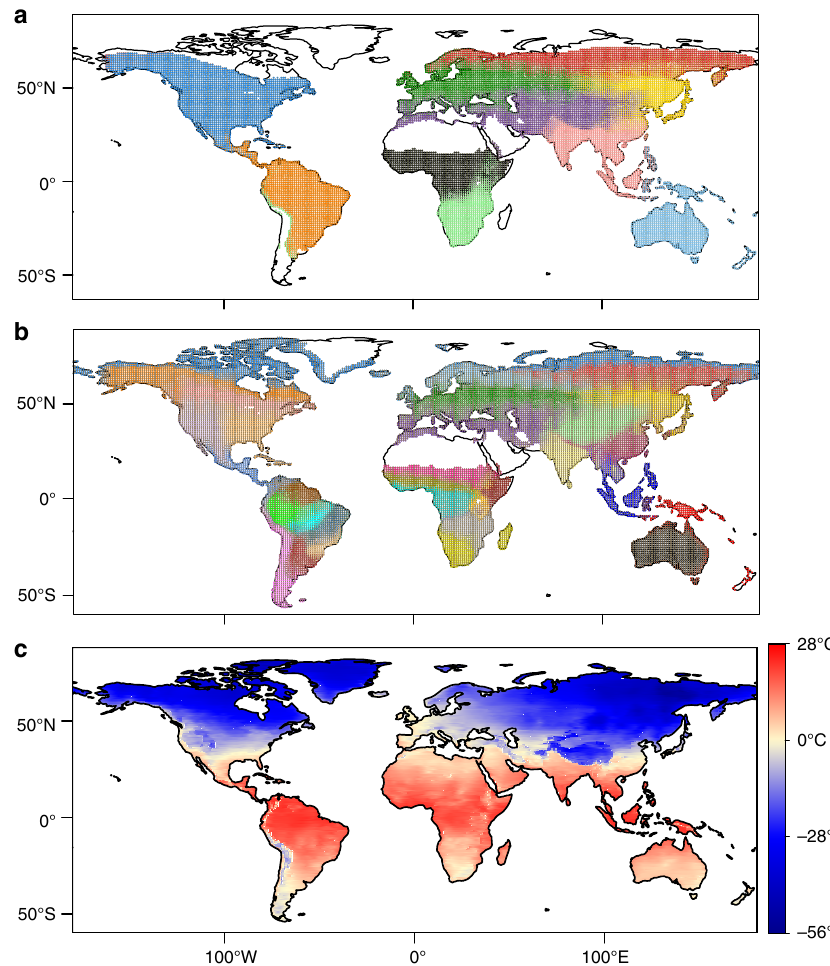
Fig. 1 Species motifs for breeding birds. a K = 11 motifs. Pie charts represent the proportional contribution of species motifs to each 1° × 1° global map cell (i.e. ω nk ). Colours represent the different motifs. Blank regions (no pie chart) contain relatively few species and are dominated by a motif that represents locations of low richness. This motif arises because of the dominance of the other ten clusters, which summarize the species composition of the majority of locations across the world. b Same as a but with K = 33. c Mean minimum temperature for the coldest month for each map cell (from worldclim.org 43 ). The freezing line is indicated by the pale-yellow coloured cells. Note the correspondence between sharp turnover of species motifs in a , b and the freezing line in c . A high-resolution version of this fi gure, where the pie chart for each map cell can be clearly viewed, is available for download on fi gshare.com (https:// fi